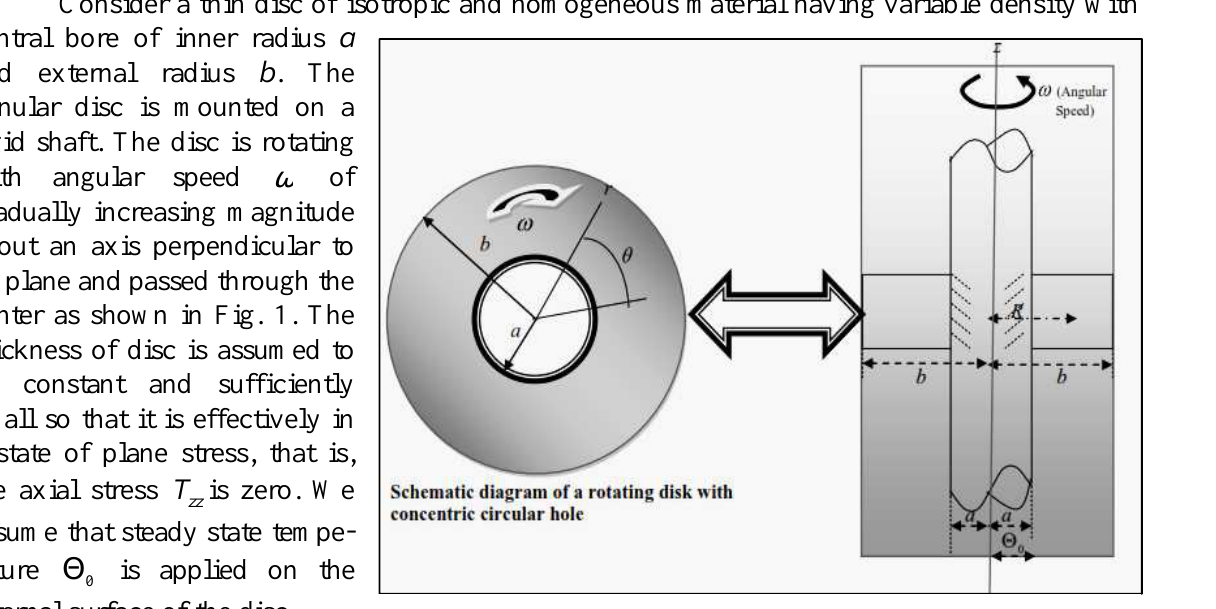
Figure 1. Geometry of Rotating